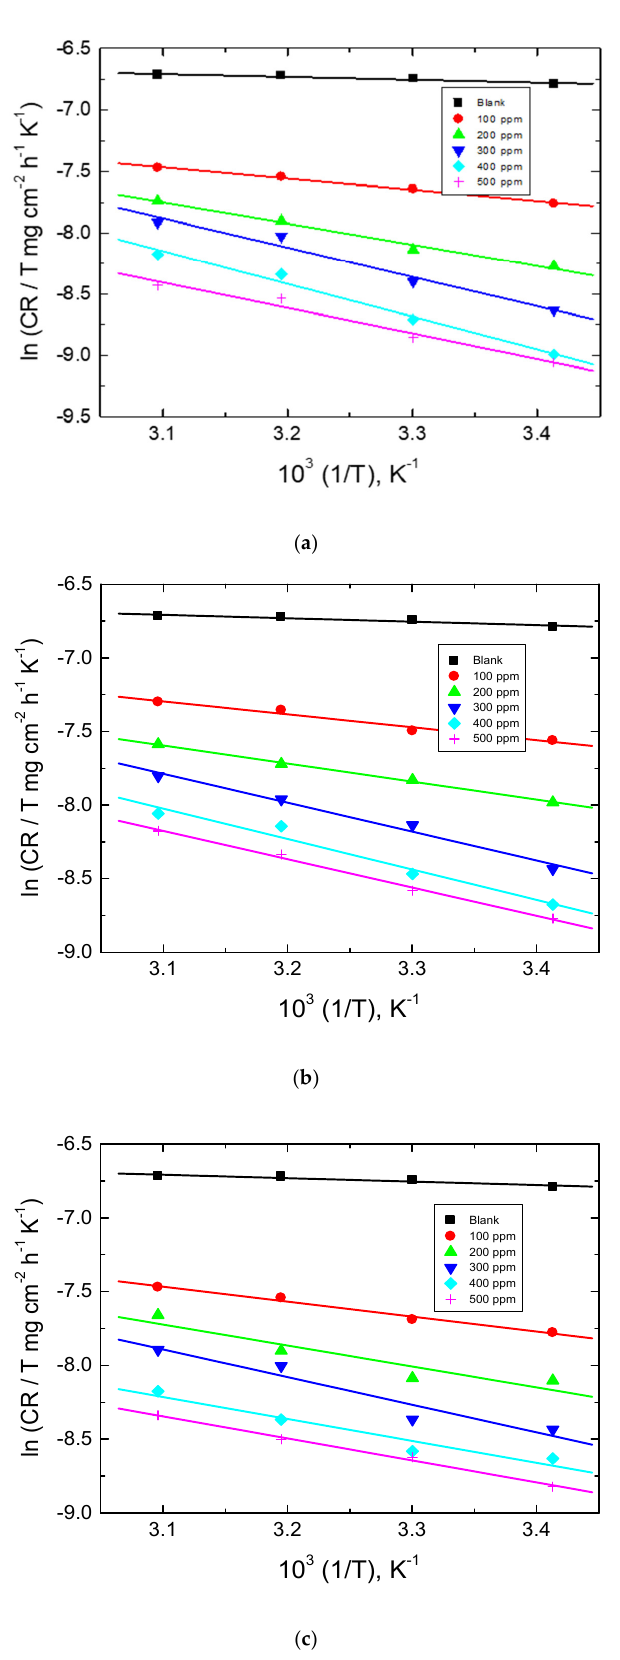
Figure 16. Transition state plots for mild-steel corrosion in 0.5 M HCl solution without and with adding numerous concentrations of the tested carbohydrate polymers: (a) Chi, (b) Pec, and (c) A-